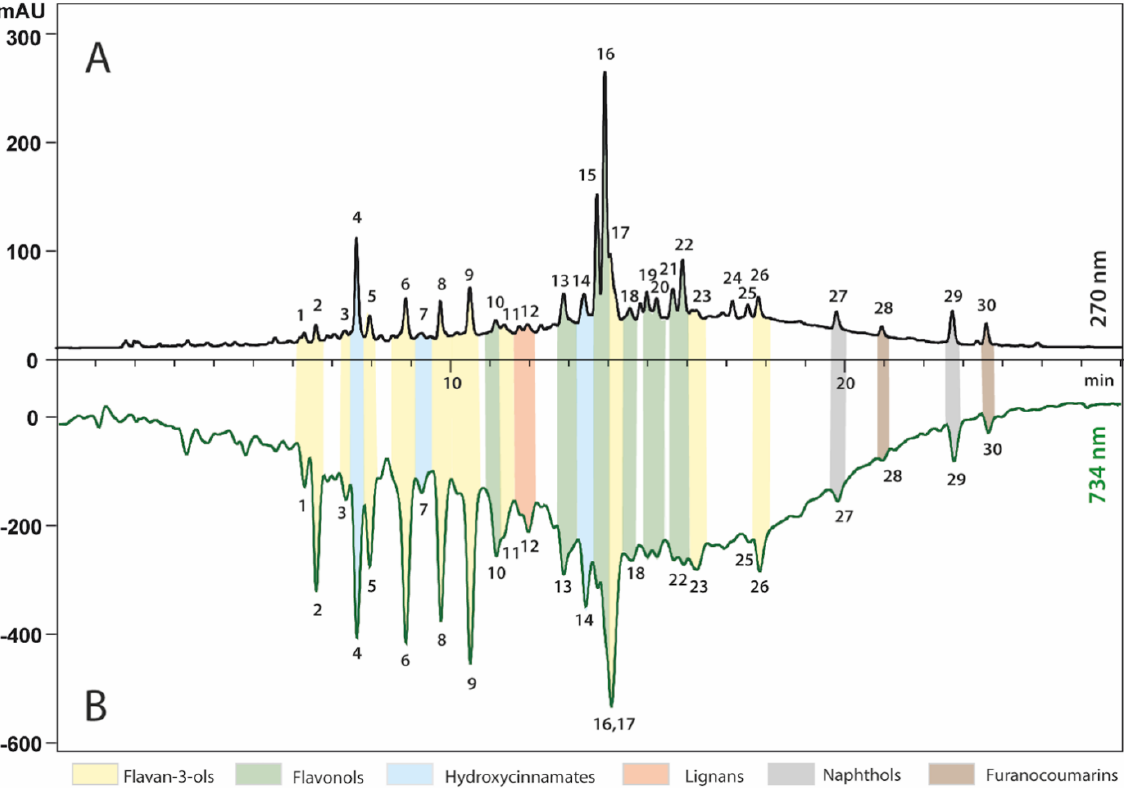
Figure 1. HPLC profiles of extracts from R. nigrum recorded before (270 nm, Panel A ) and after (734 nm, Panel B ) post-column derivatization with ABTS. For identity of peaks, see Table